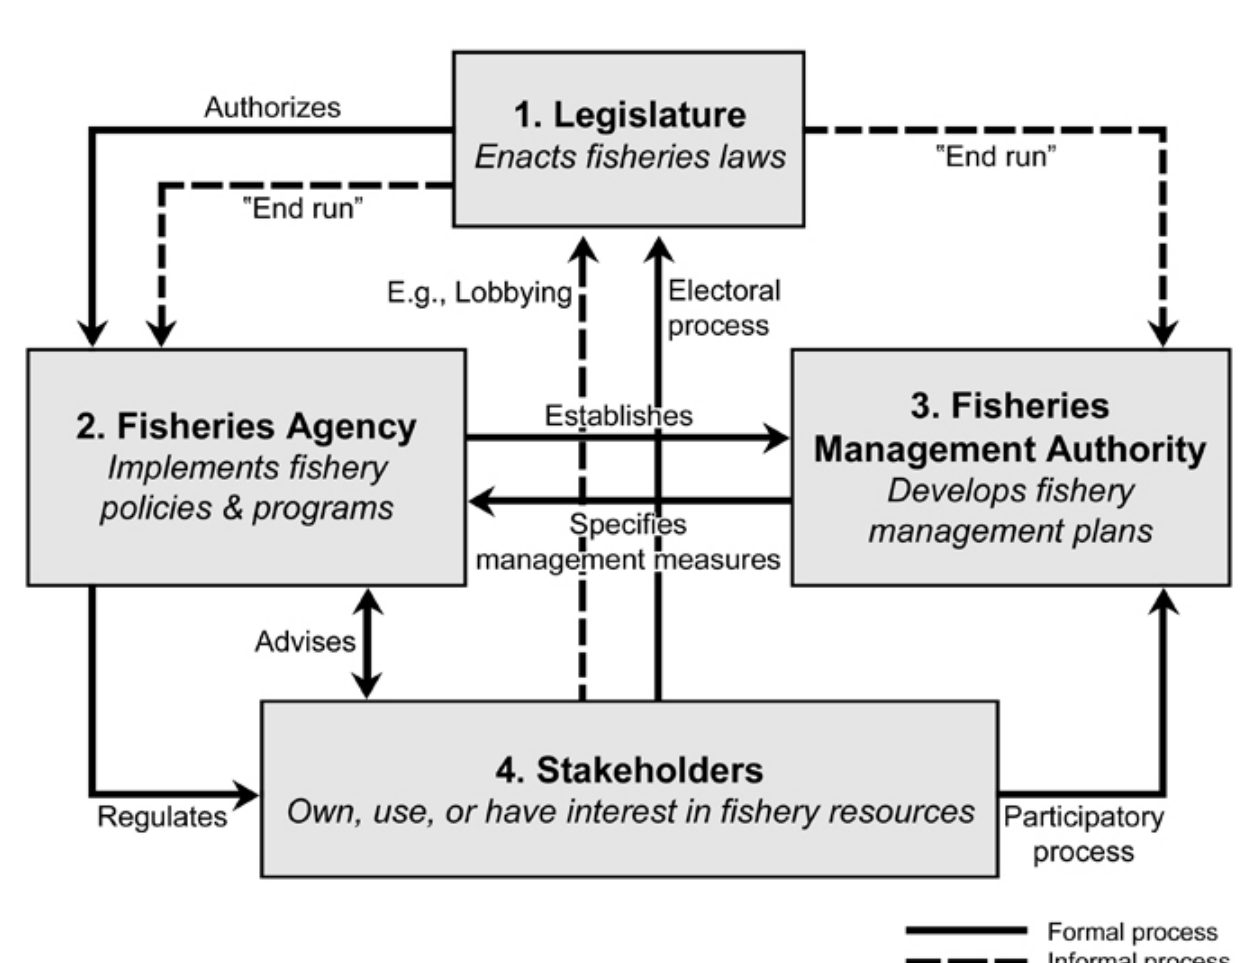
Fig. 2. Fisheries governance system (modified from Sutinen and Soboil